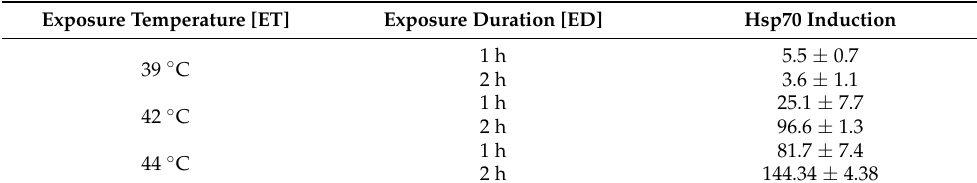
Table 1. Heat-stress model of SH-SY5Y. The Hsp70 gene expression fold-change values were cal- culated from six circumstances involving a combination of three exposure temperatures (ET) and two exposure durations (ED).